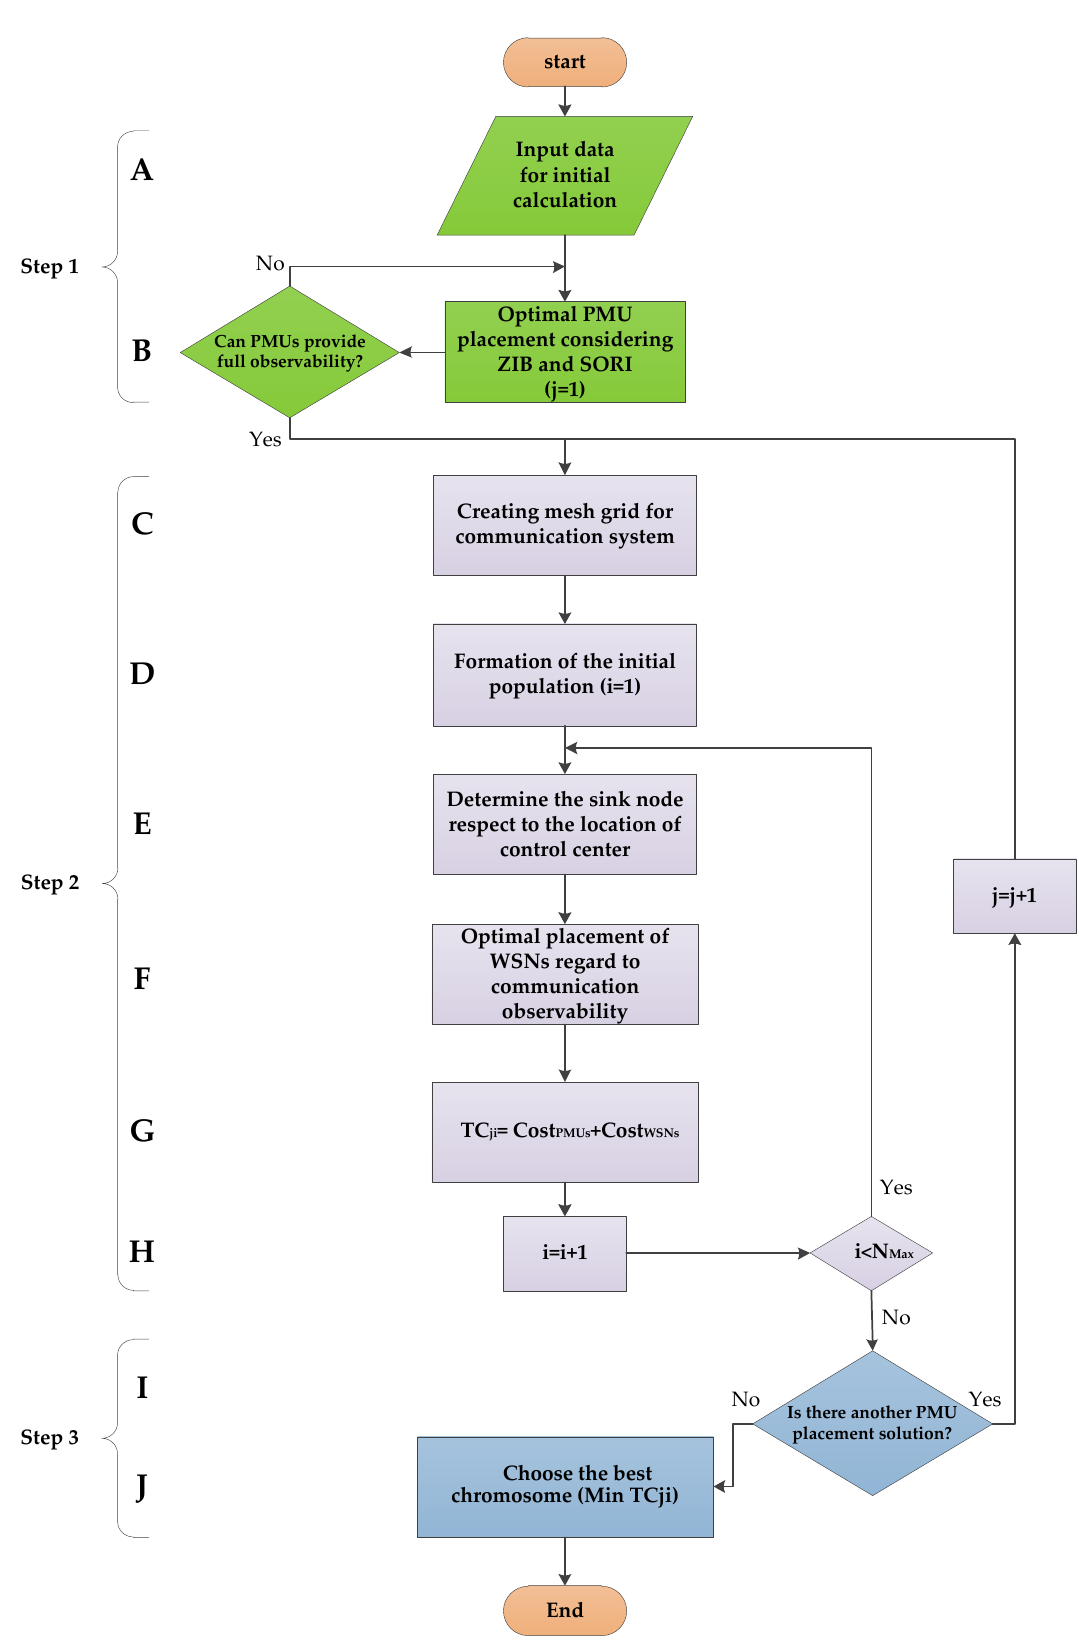
Figure 5. Flowchart of the proposed method. ZIB, zero-injection bus; SORI, system observability redundancy index.